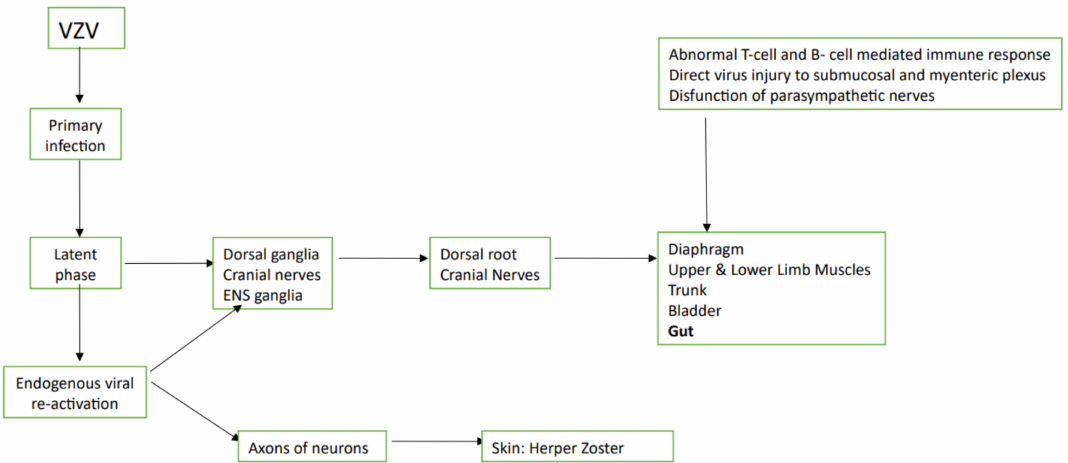
Figure 1. Pathogenesis if varicella-zoster infection is present. ENS: enteric nervous system; VZV: varicella-zoster